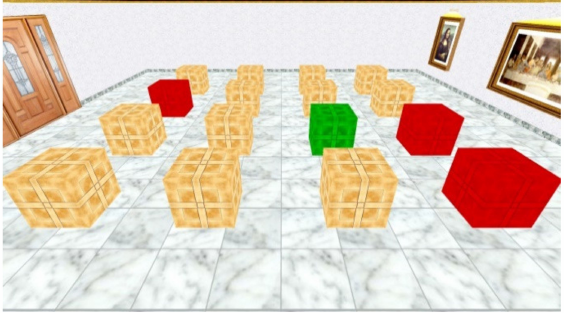
Figure 2. View of the virtual room in the NWSBRT. Note that the context is the same as in the WSBRT and ASMRT